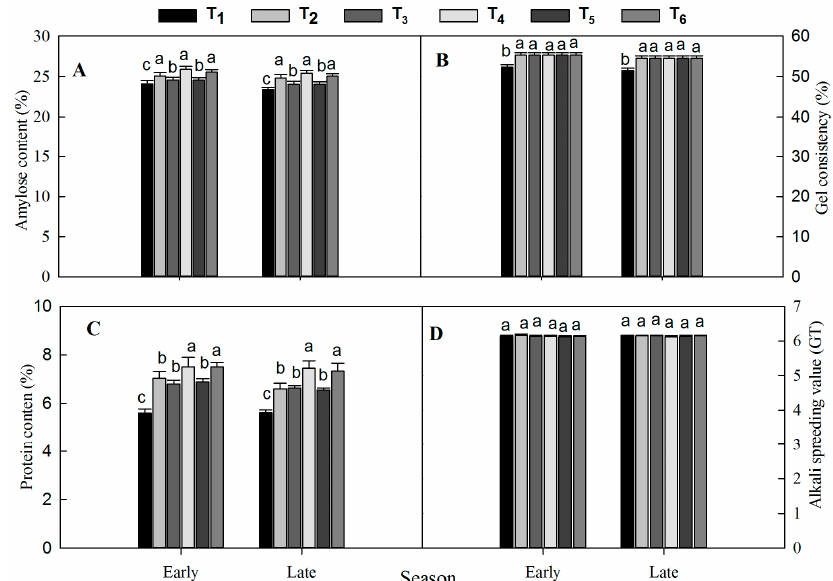
Figure 3. Changes in amylose content ( A ), gel consistency ( B ), protein content ( C ) and alkali spreading value (GT) ( D ) of rice during both seasons under organic and inorganic fertilizer application. Vertical bars represent the standard error of mean. Different letters above the column indicate statistical significance at the p < 0.05. Note—T 1 : no N fertilizer, T 2 : 100%CF, T 3 : 60% CM + 40% CF, T 4 : 30% CM + 70% CF, T 5 : 60% PM + 40% CF, T 6 : 30% PM + 70% CF.